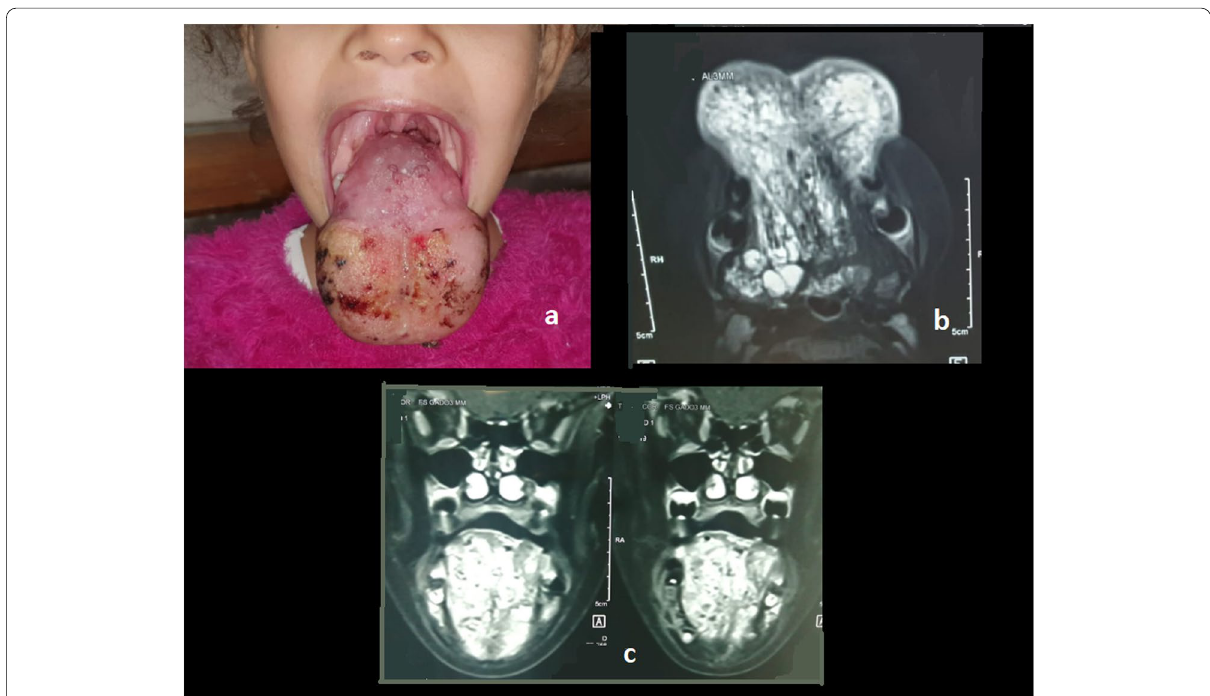
Fig. 2 Clinical and radiological findings in patient 2. a Clinical lesions of the patients 2. b Axial sections of MRI showing infiltration to the floor of mouth of the cystic lesion of the tongue. c Coronal sections of MRI showing the cystic lesion taking on the totality of the